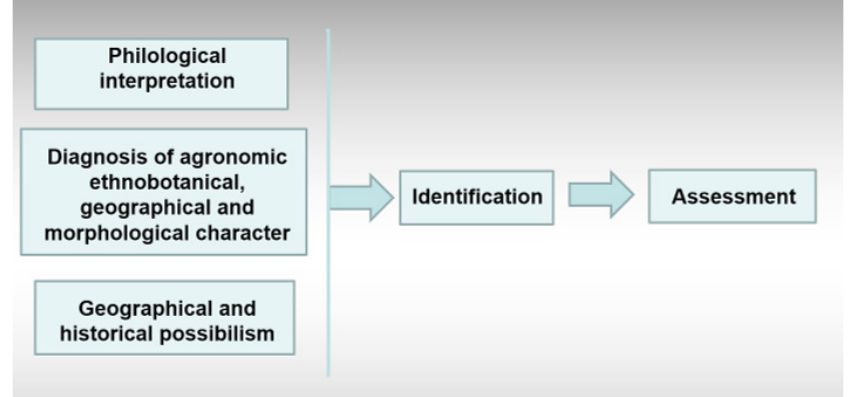
Figure1. Working